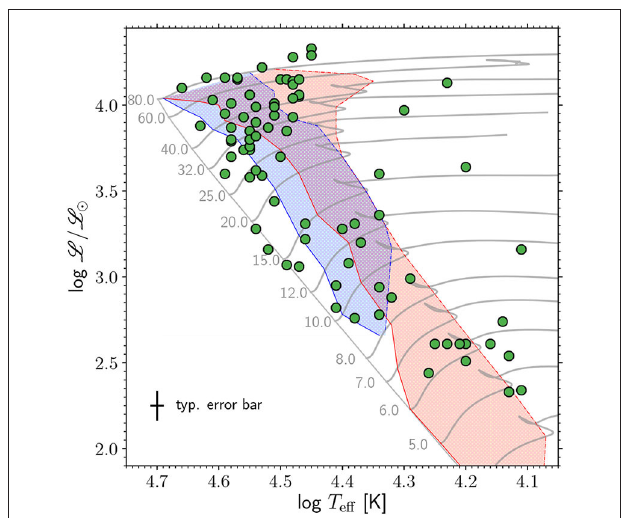
FIGURE 4 | Spectroscopic HR diagram of the pulsating massive stars observed by TESS in its sectors 1–13, which have spectroscopic parameters derived by high-resolution spectroscopy, are shown as green circles. Note that the ordinate axis shows spectroscopic luminosity such that L : (Langer and Kudritzki, 2014). Red and blue hatched regions denote the theoretical instability regions of g and p modes, respectively, for main sequence stars. Non-rotating evolutionary tracks at solar metallicity (in units of M shown as solid gray lines, and a typical spectroscopic error bar is shown in the bottom-left corner. Figure adapted from Burssens et al. (2020), their Figure